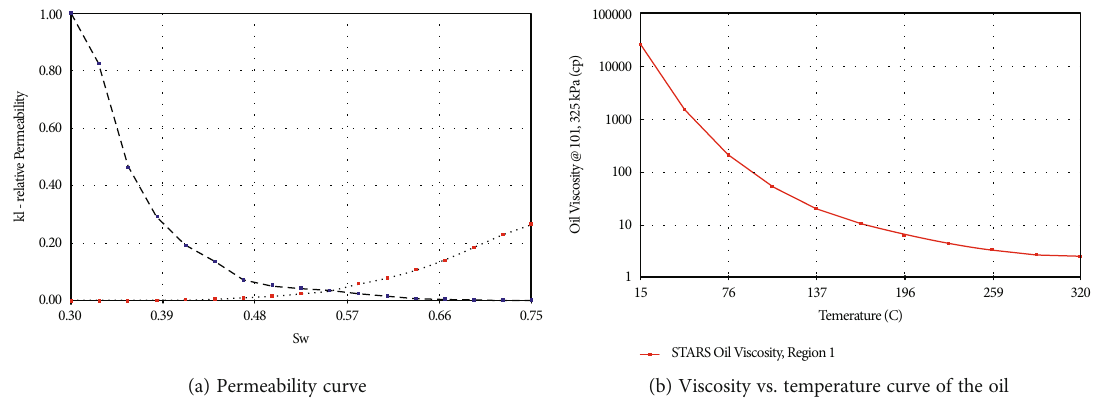
Figure 20: Fluid ’ s property curve.